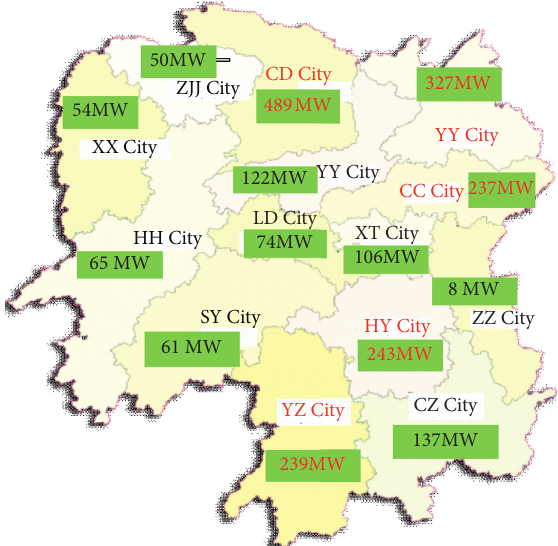
Figure 1: Distribution of the distributed photovoltaic generation in Hunan Table 1: Frequency response time requirements of distributed generation.